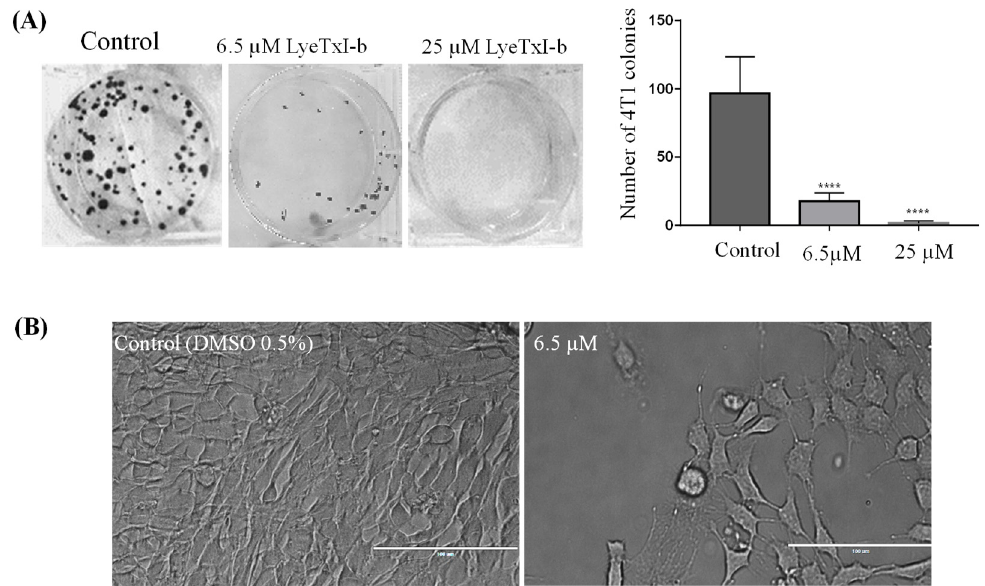
Figure 1. Quantification of the survival of 4T1 single cell colonies after the treatment with LyeTx I-b (IC 50 and IC 80 ). The IC 50 and IC 80 were determined by the MTT method. Representative images of colonies of 4T1 after 10 days ( A ) and morphology of untreated (control) and treated cells with IC 50 concentration of peptide ( B ) are shown. Data represent the mean ± SD of duplicates of three independent experiments, One-way ANOVA followed by Dunnett’s comparison test, **** p < 0.0001 compared to the control group.